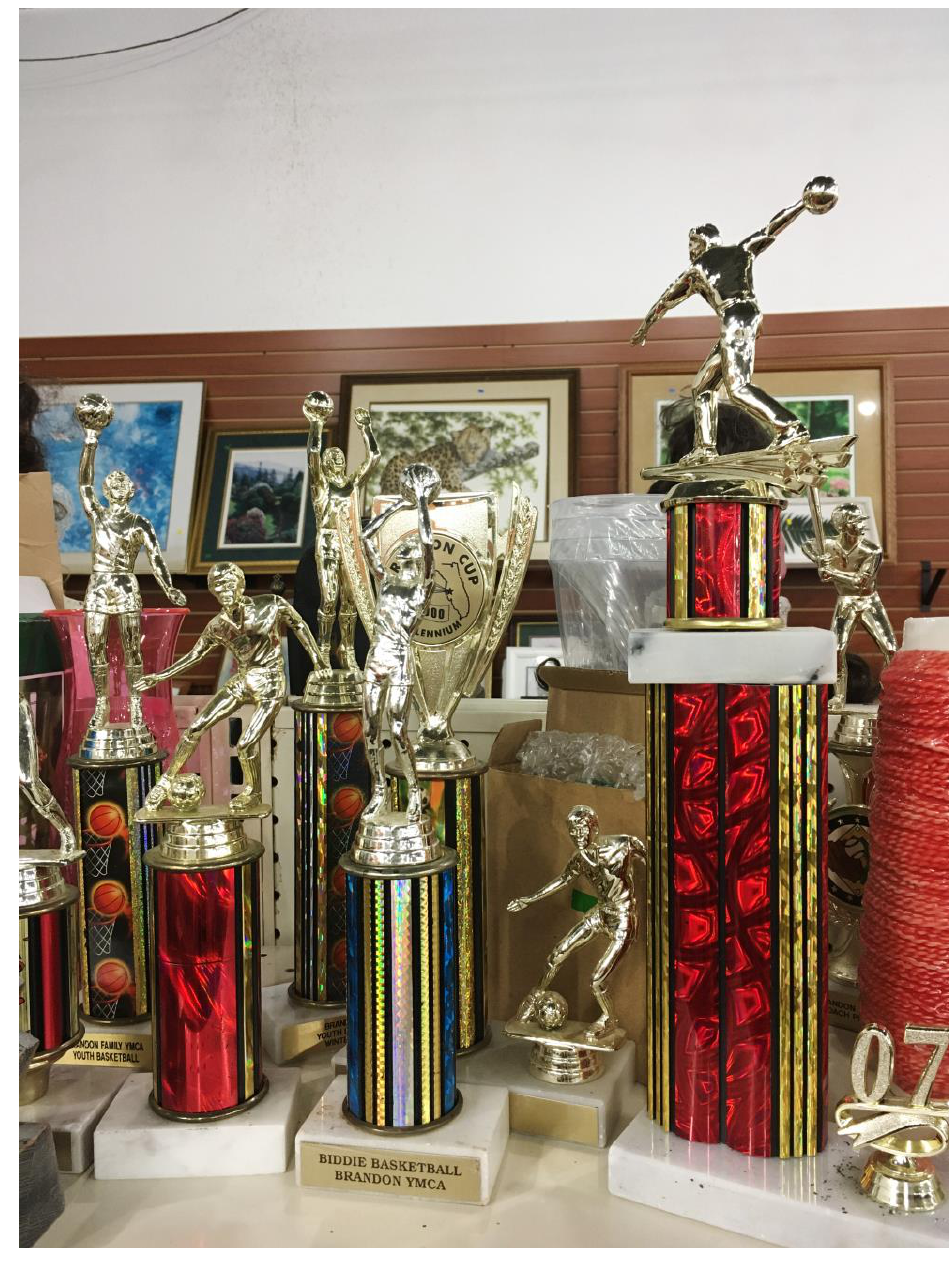
Figure 4 Jezabeth Roca Gonzalez, Gringolandia , 2017-2018,